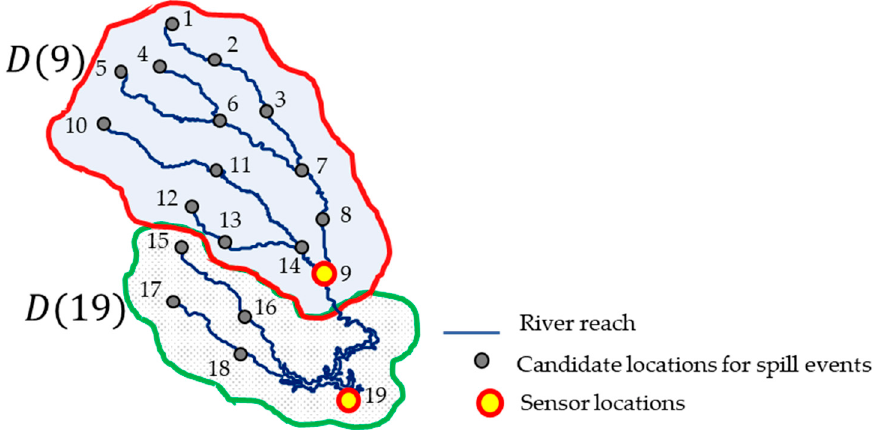
(cid:16) (cid:17) Figure 3. Examples of 𝐷(cid:3435)𝑦 (cid:3037) (cid:3439) when sensors are installed at locations 9 and 19. y j Figure 3. Examples of D when sensors are installed at locations 9 and